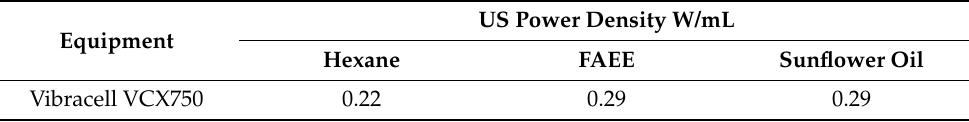
Table 2. US energy depending on the equipment and extraction solvent (determined at 60 °C).